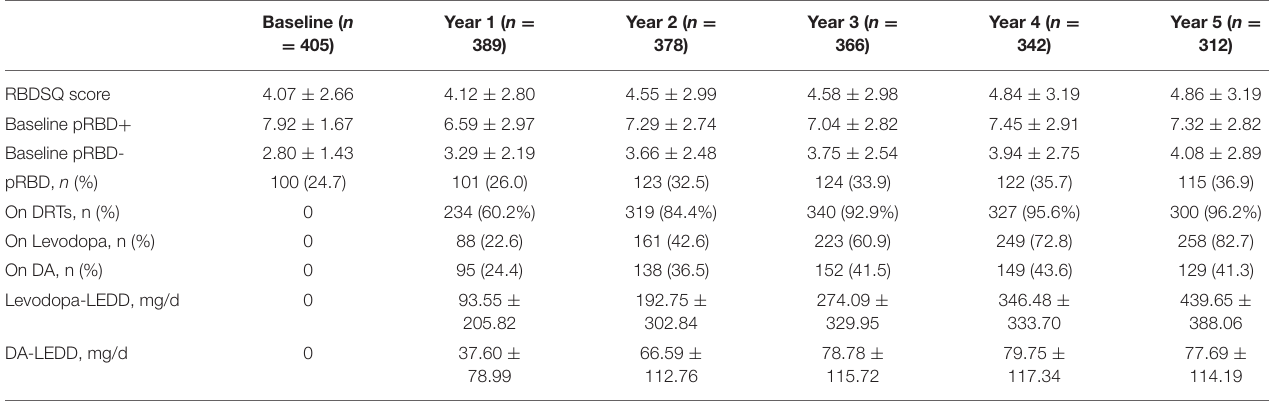
TABLE 2 | Baseline and follow-up data on RBD assessment and medication status.